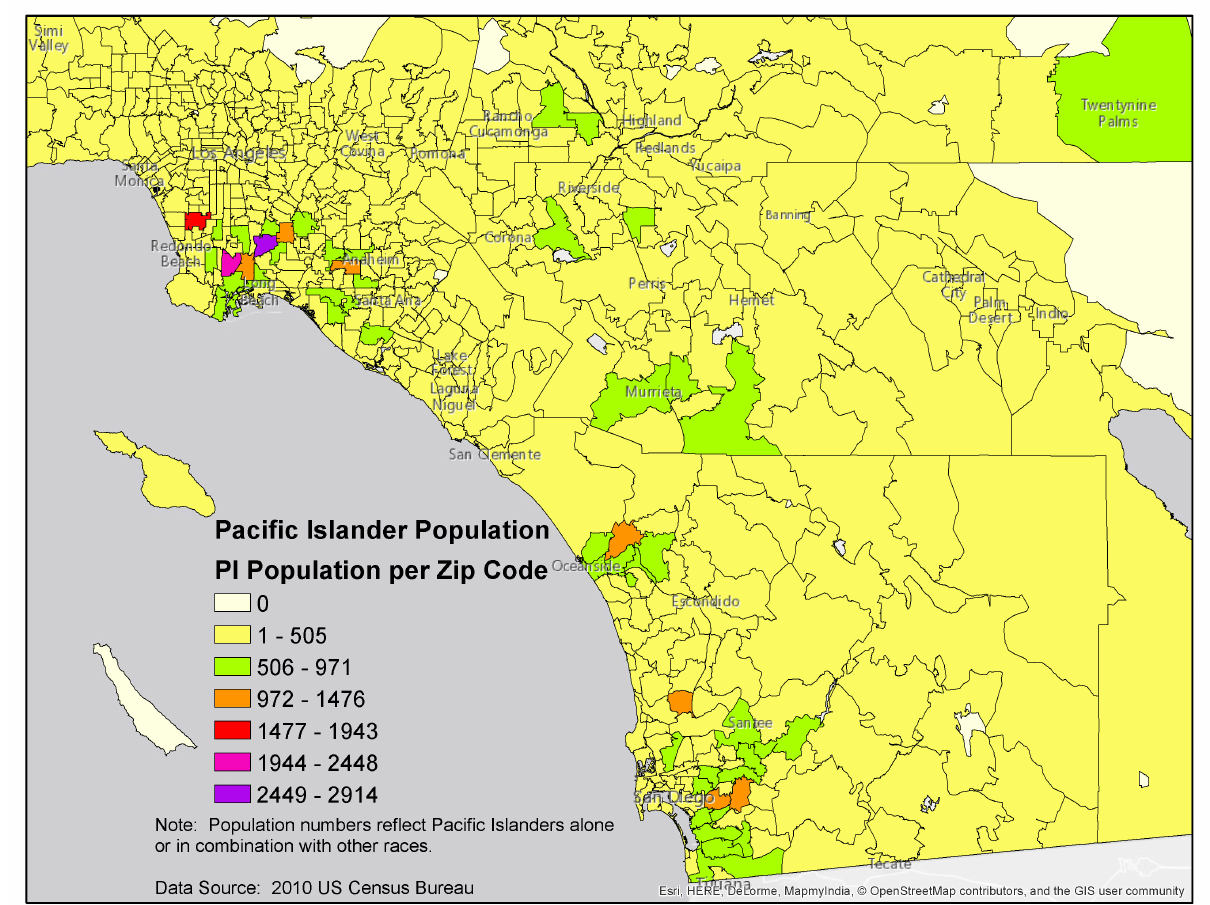
Figure 1. Geographic distribution of Pacific Islanders in Southern